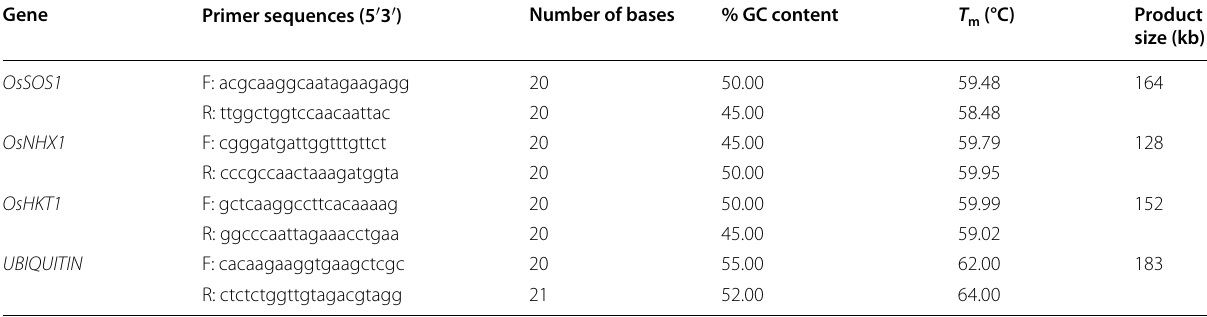
Table 2 Primers used for RT-qPCR